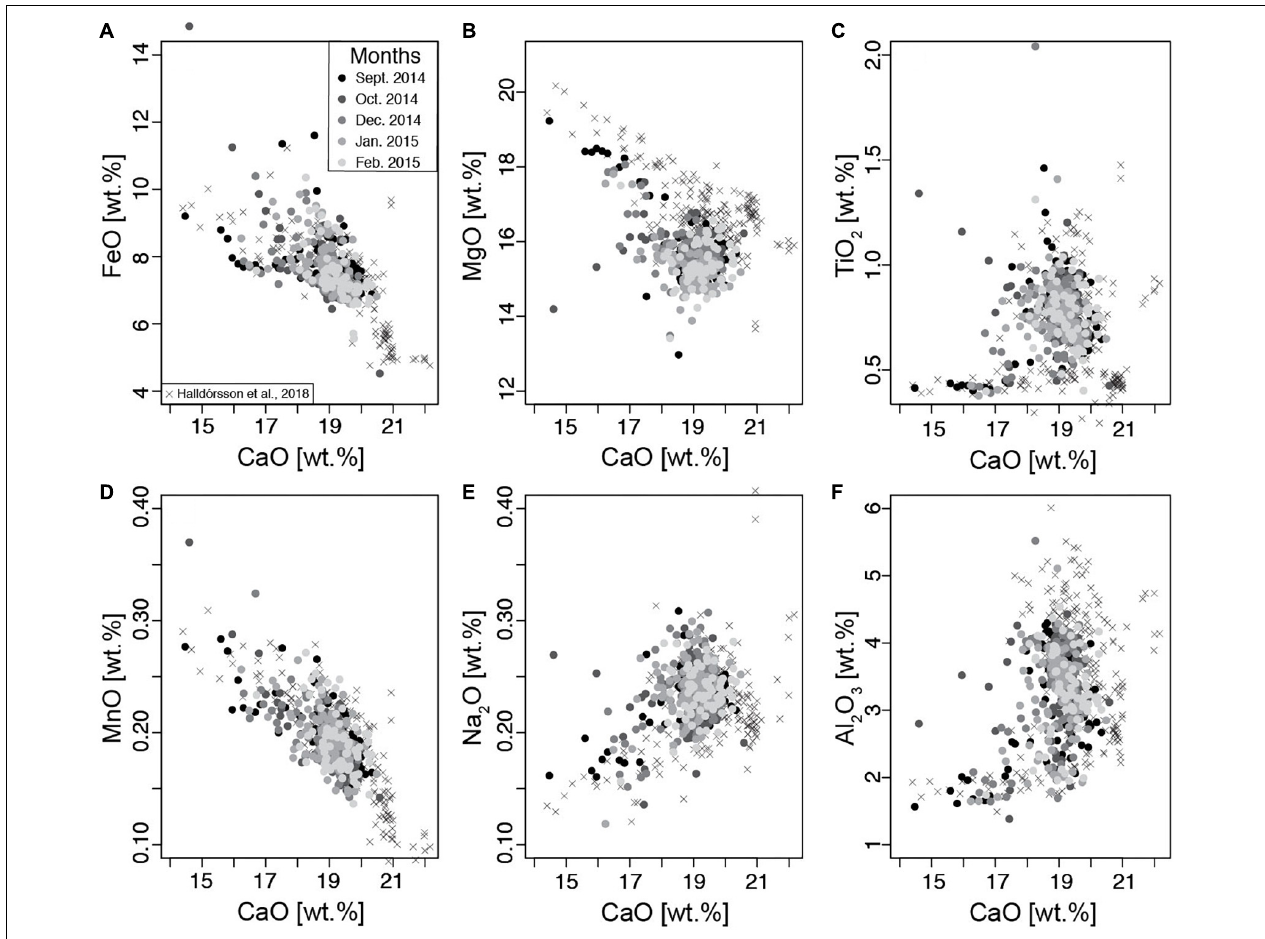
FIGURE 3 | (A–F) Major element clinopyroxene analyses. The gray-scale represents the different periods over which the samples were collected. No obvious relationship is visible between clinopyroxene chemistry and eruption